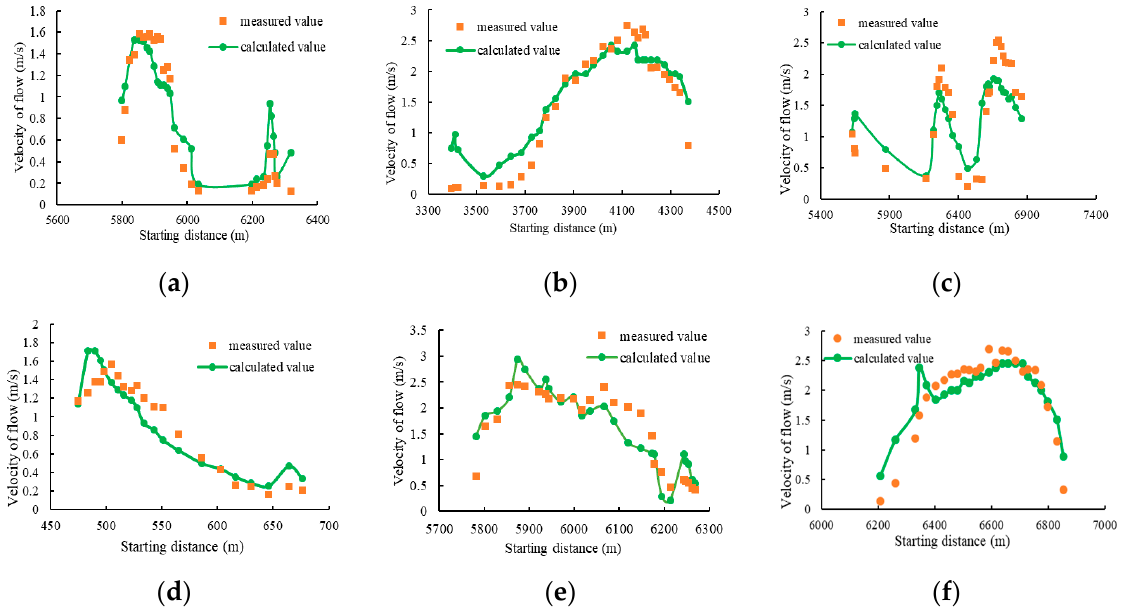
Figure 3. Verification of transverse velocity distribution by flow data before, and during flood season: ( a ) Tiexie, 24 April 1966 (before flood season); ( b ) Peiyu, 23 July 1966 (flood season); ( c ) Guanzhuangyu, 1 April 1966 (before flood season); ( d ) Huayuankou, 23 May 1966 (flood season); ( e ) Tiexie, 2 July 1966 (flood season); ( f ) Guanzhuangyu, 24 July 1966 (flood season).